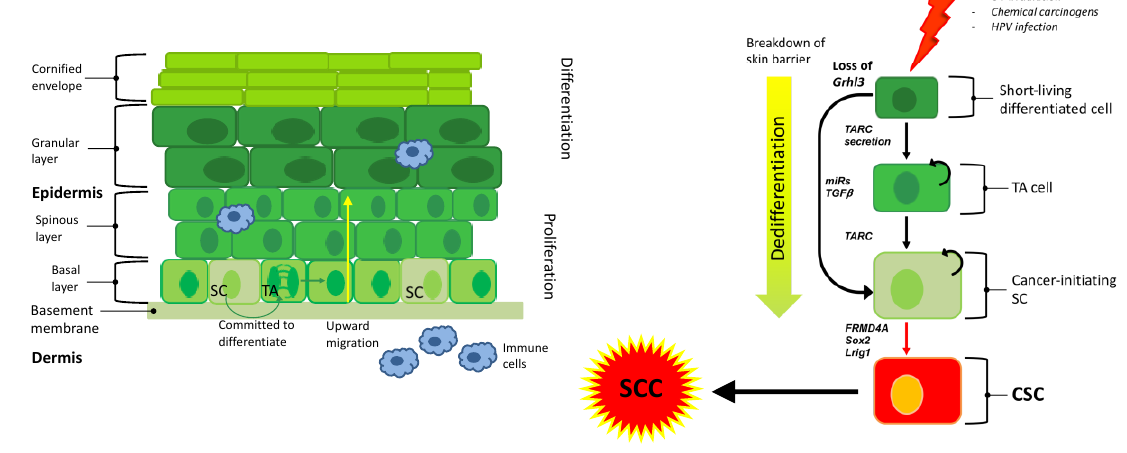
Figure 1. Exposure to environmental assaults transform SC or dedifferentiate a differentiated cell through the expression of secreted factors or activation of specific oncogenes. This cell becomes a CIC that give rise to a CSC and ultimately to SCC. Transit amplifying (TA), stem cell (SC), cancer stem cell (CSC), squamous cell carcinoma (SCC).